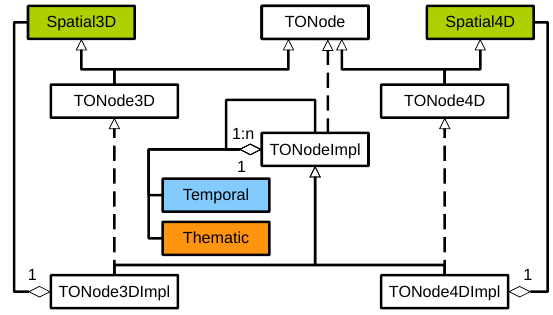
Figure 5. Property Graph Model , which follows OGCs General Feature Model (Jahn and Bradley, 2021)